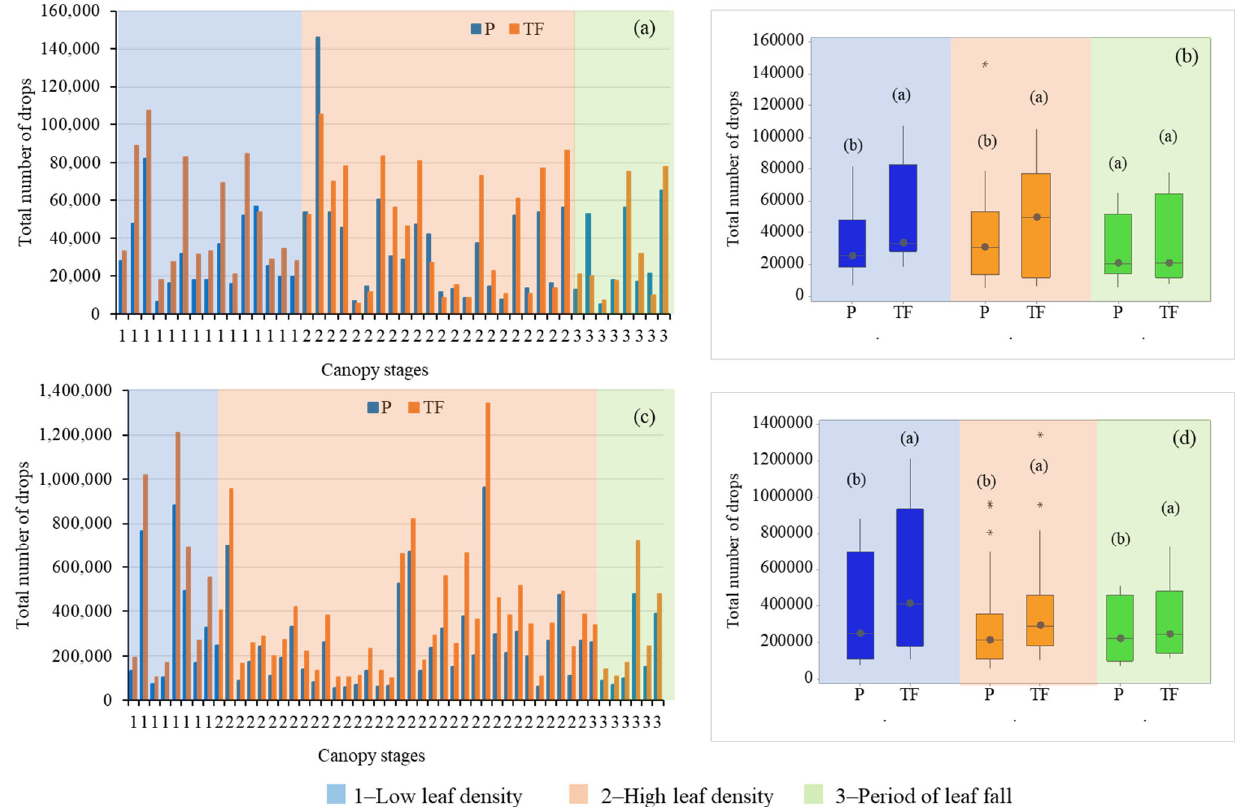
Figure 7. Total number of drops of gross rainfall (P) and throughfall (TF) for the three stages of canopy development: (Figures a , b ) at the top means P ≤ 5.0 mm and (Figure c , d at the bottom means) P > 5.0 mm. * The colors in the figures indicate the different stages of canopy development. * Different letters (a, b) represent a statistically different median at the level of 1% by the Wilcoxon test.